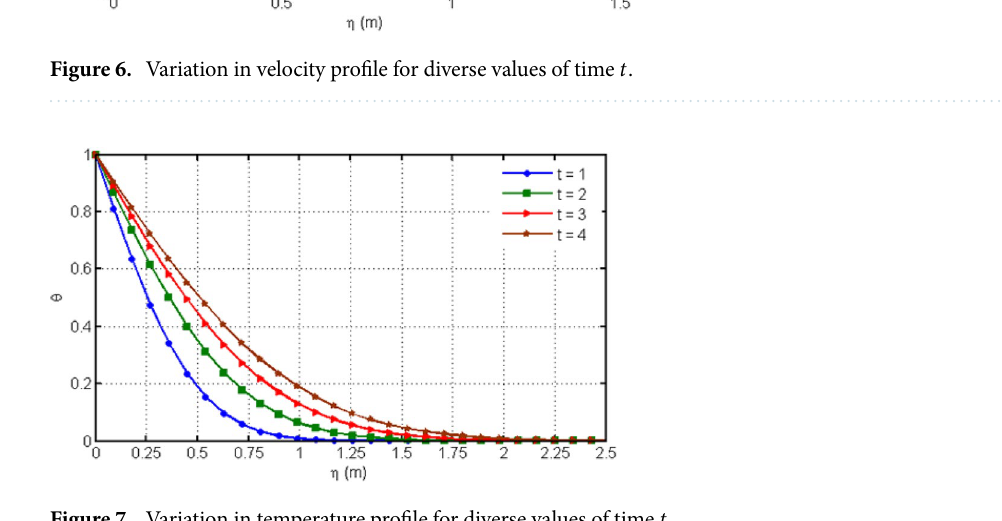
Figure 7. Variation in temperature profile for diverse values of time t